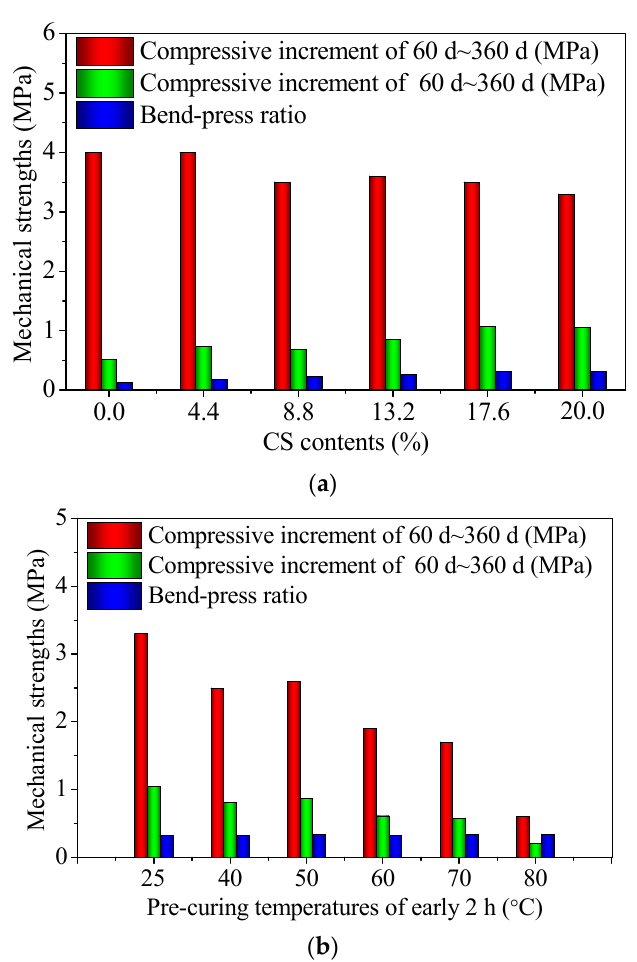
Figure 10. The bend-press ratios and the increments in flexural and compressive strengths of 60 d~360 d for CS − FA − GEO composites: ( a ) with different CS contents, and ( b ) at different pre-curing temperatures.